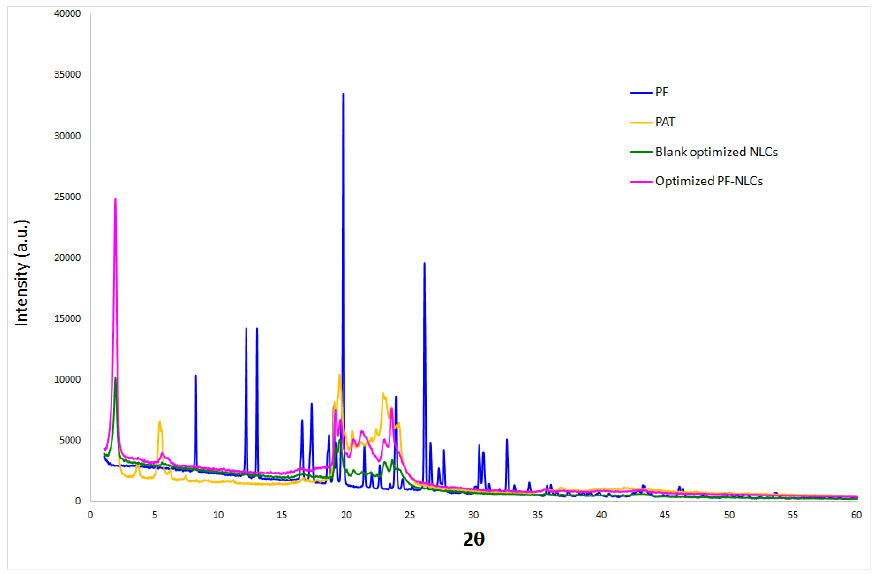
Figure 2. X-Ray diffraction patterns.